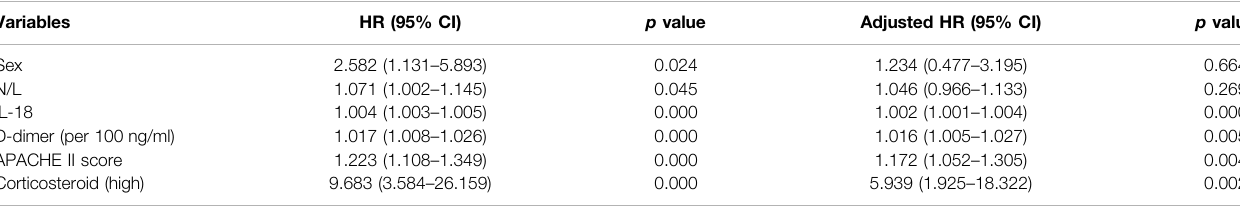
APACHE II: acute physiology and chronic health evaluation; CI: con fi dence interval; HR: hazard ratio; IL-18: interleukin-18; N/L: the ratio of neutrophils/lymphocyte. HR (95% CI) represent univariable Cox regression analysis. Adjusted HR (95% CI) represent multivariate Cox regression